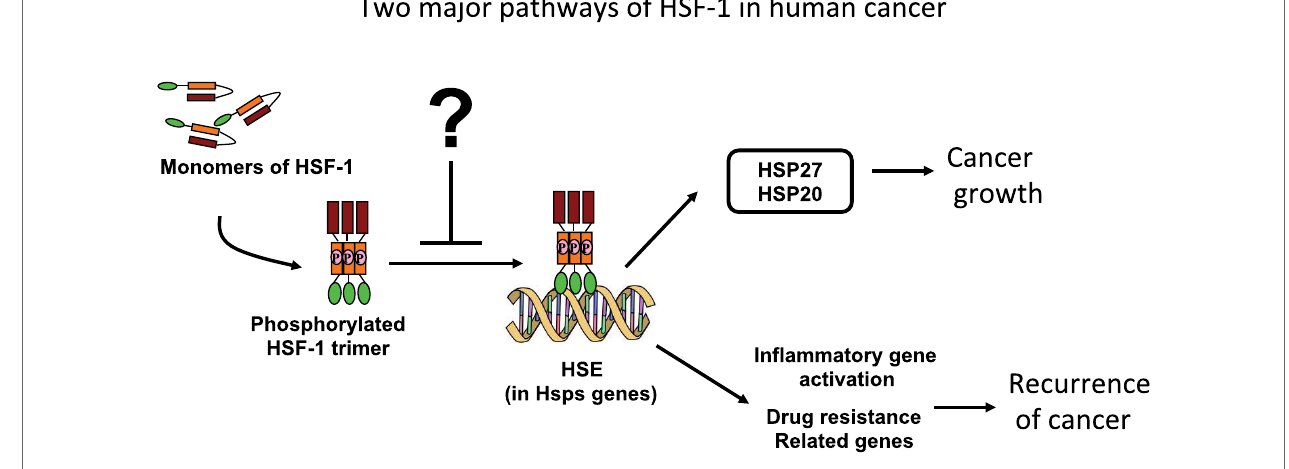
Figure 1 | Schematic illustrations of pathways by which the heat-shock proteins (HSPs) interfere in human cancer prognosis.